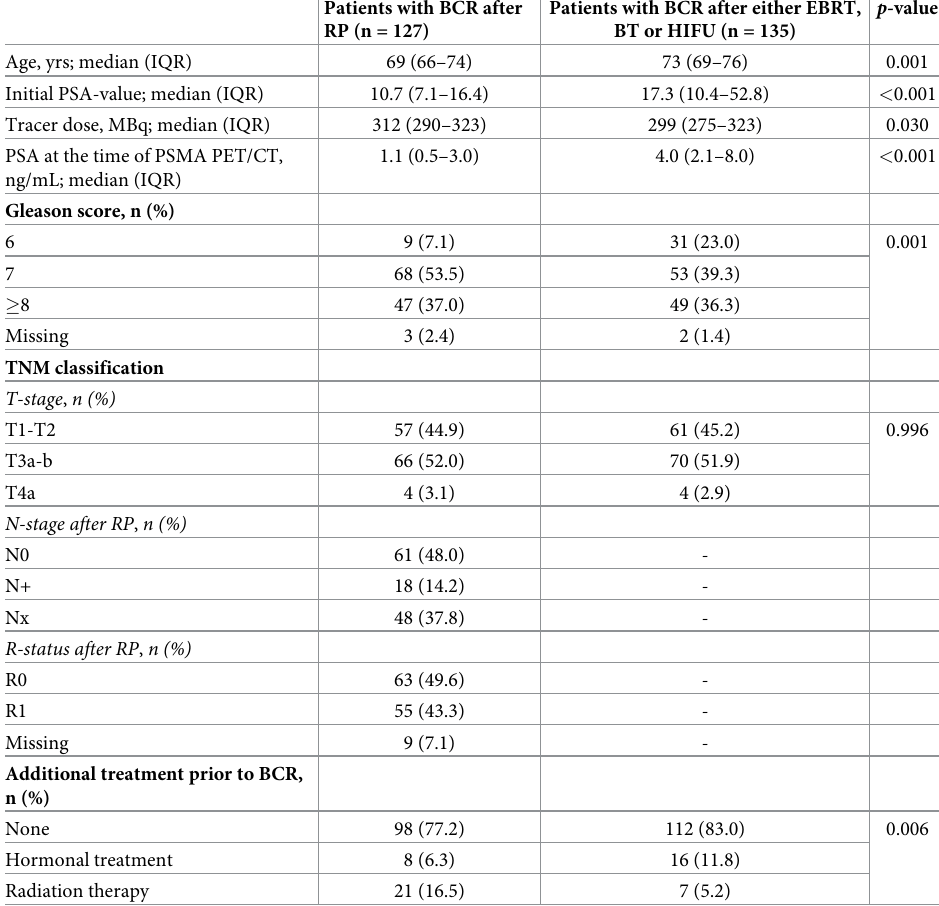
Table 1. Characteristics of patients with BCR, subsequently scanned with 18 F-DCFPyL PET/CT, stratified for their primary treatment.